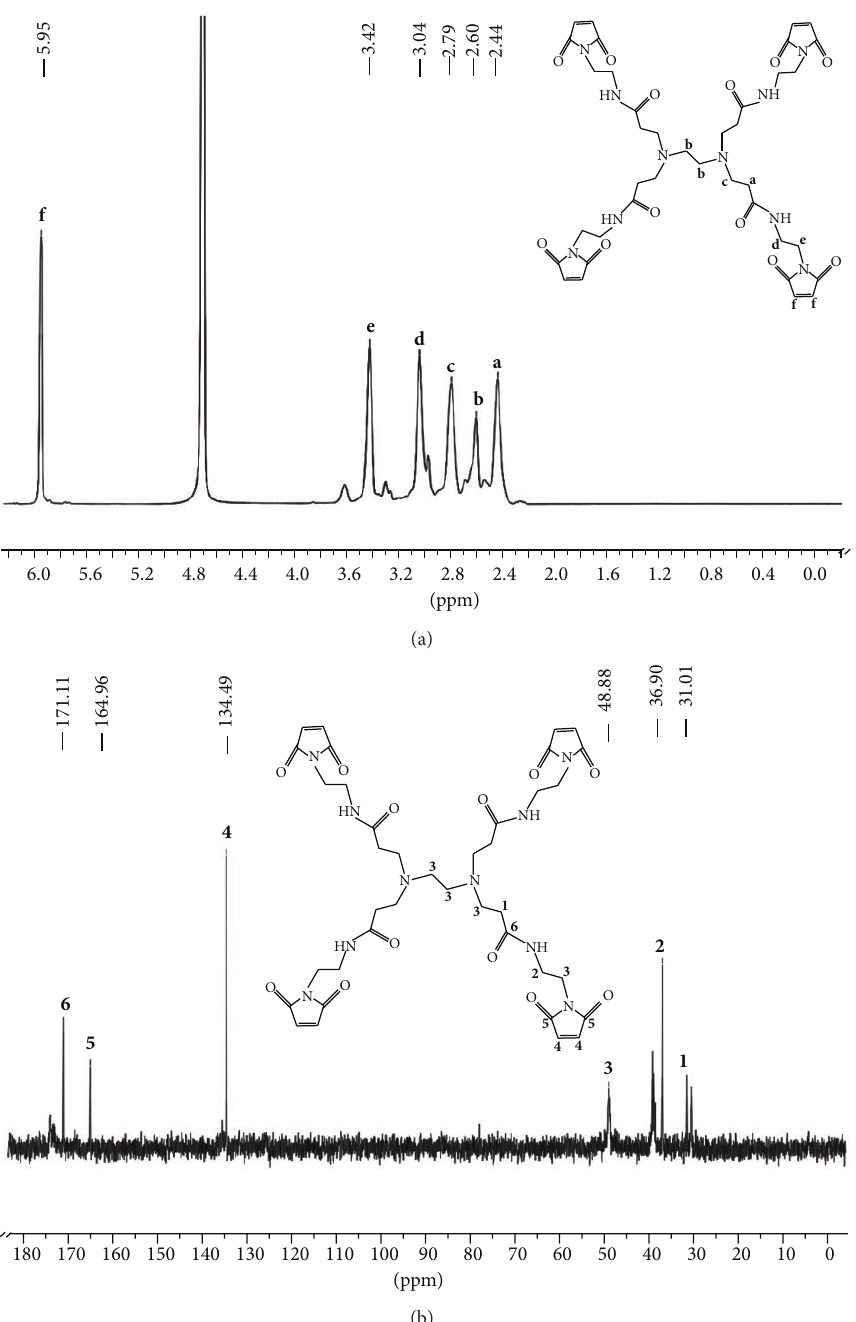
Figure 3: (a) 1 H NMR spectrum of the dendrite functional monomer in D 2 O; (b) 13 C NMR spectrum of the dendrite functional monomer in D 2